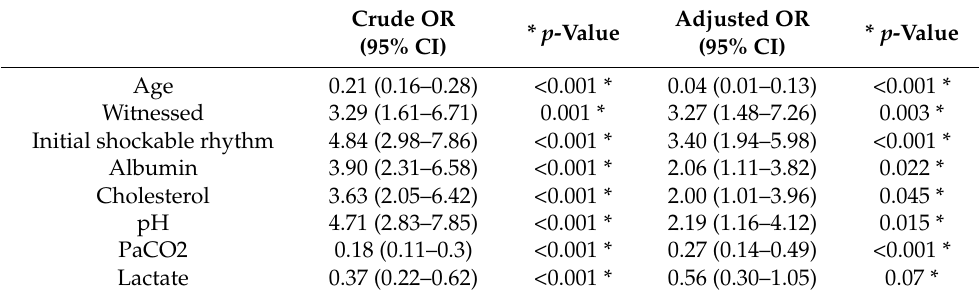
Table 4. Multivariate logistic regression of out-of-hospital cardiac arrest patients with neurologic outcome.